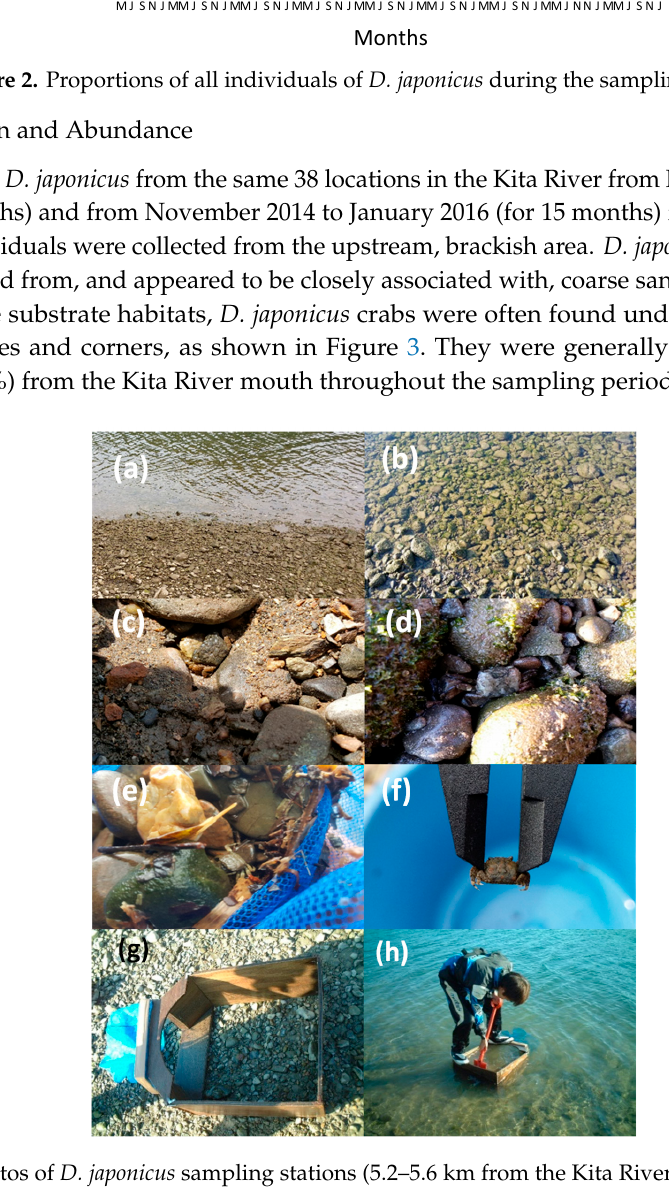
Figure 3. Photos of D. japonicus sampling stations (5.2–5.6 km from the Kita River mouth): ( a ) 5.2 km habitat point, ( b ) 5.6 km habitat point, ( c ) enlarged image of a, ( d ) enlarged image of b, ( e ) sample collection using a quadrat trap with a net, ( f ) body size measurement using Vernier calipers, ( g ) quadrat trap with a net used in this study, and ( h ) field sampling demonstration.